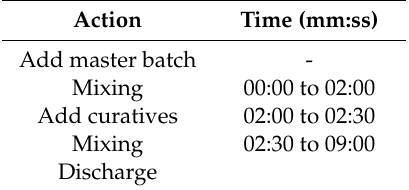
Table 3. Final mixing procedure for A as well as for